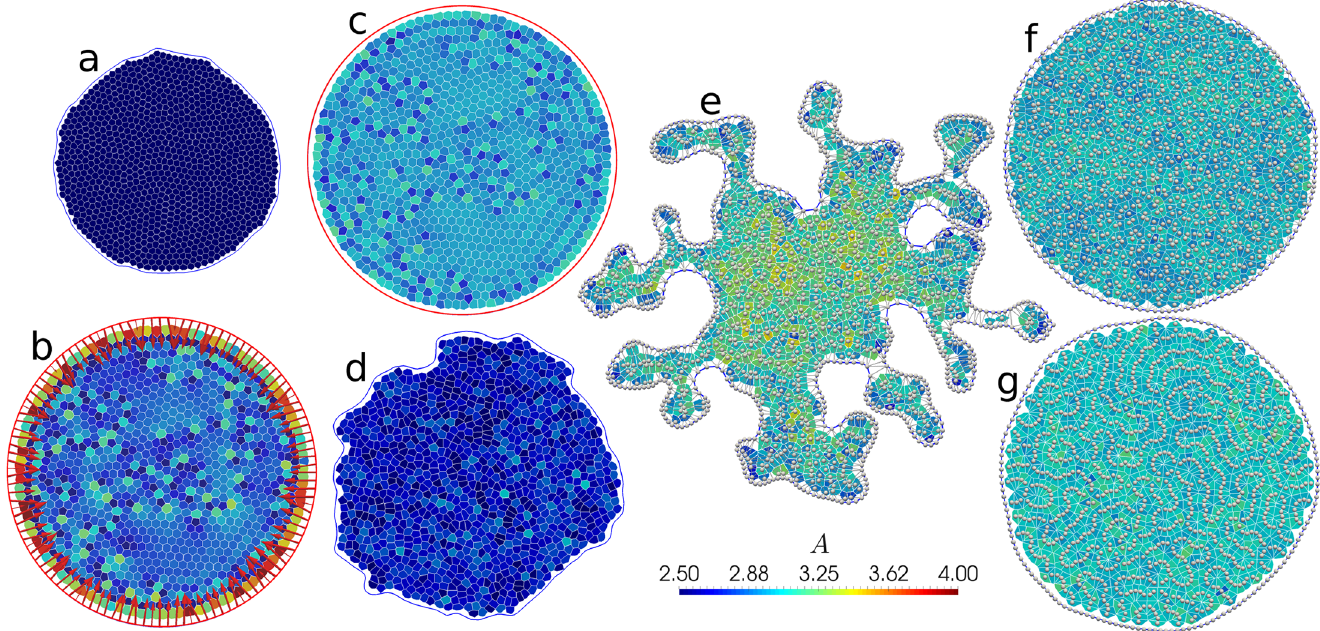
Fig 6. Representative snapshots of states seen with fixed and flexible boundaries in the AVM. Contact lines betweencells are outlinedin white, and cells are colouredaccordingto their area. The line connectingtissue boundarypoints is blue for flexibleboundaries(panels a, d, e, f and g), and red for fixed ones (panelsb and c). In panelse, f and g, cell centres are denotedby white spheres, and in panelse and f, the Delaunaytriangulation is also shown ¼ 0 : 01 and f a = 0.1, no boundaryline tension. (b) Same as (a), but for a fixed boundary.(c) Solid- as grey lines. (a) Shrinkingcells at p 0 = 2.48, Γ = 1.0, t (cid:0) 1 r ¼ 0 : 1 and f a = 0.03. (d) Liquid-likestate with a fluctuatingboundaryat p 0 = 3.39, Γ = 1.0, t (cid:0) 1 ¼ 0 : 1 and f a = 0.3, like (glassy) state at p 0 = 3.39, Γ = 1.0, t (cid:0) 1 r r no boundary line tension (e) Fingeringinstability at p ¼ 0 : 1 and f a = 0.1, boundaryline tension λ = 0.3. (g) Rosette formation at p 0 = 4.85, Γ = 0.1, t (cid:0) 1 ¼ 0 : 1 and f a = 0.03, boundaryline tension r r λ = 0.3.